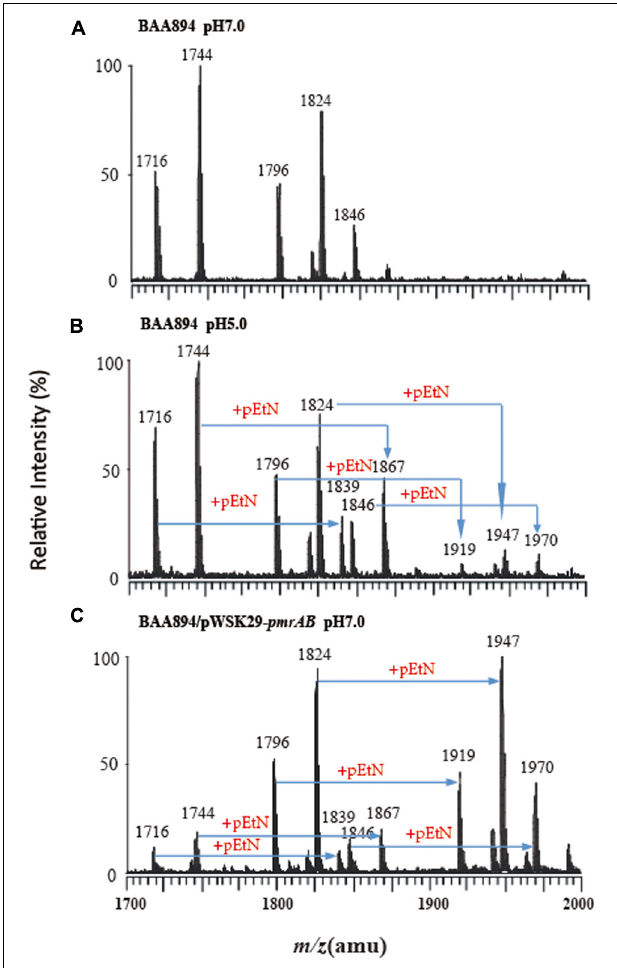
FIGURE 1 | Mass spectrometry analysis of lipid A isolated from C. sakazakii and C. sakazakii/ pWSK29- pmrAB . (A) C. sakazakii grown at pH 7.0. (B) C. sakazakii grown at pH 5.0. (C) C. sakazakii /pWSK29- pmrAB grown at pH 7.0.